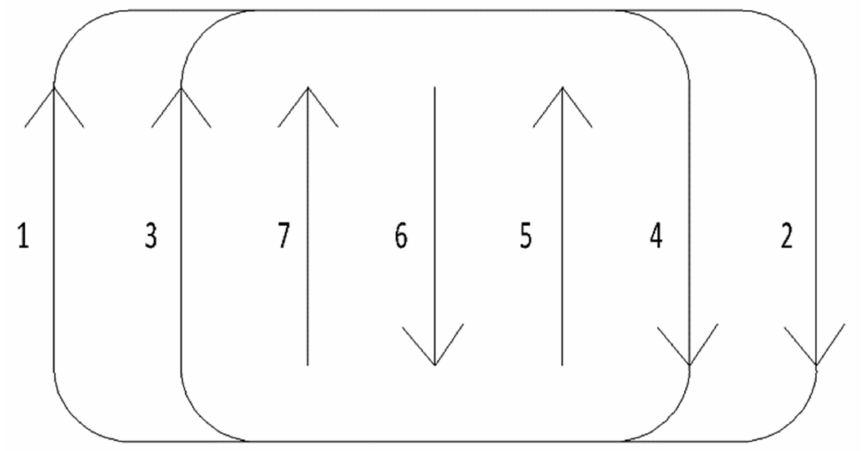
Figure 9. Full-field path planning schematic of the combine